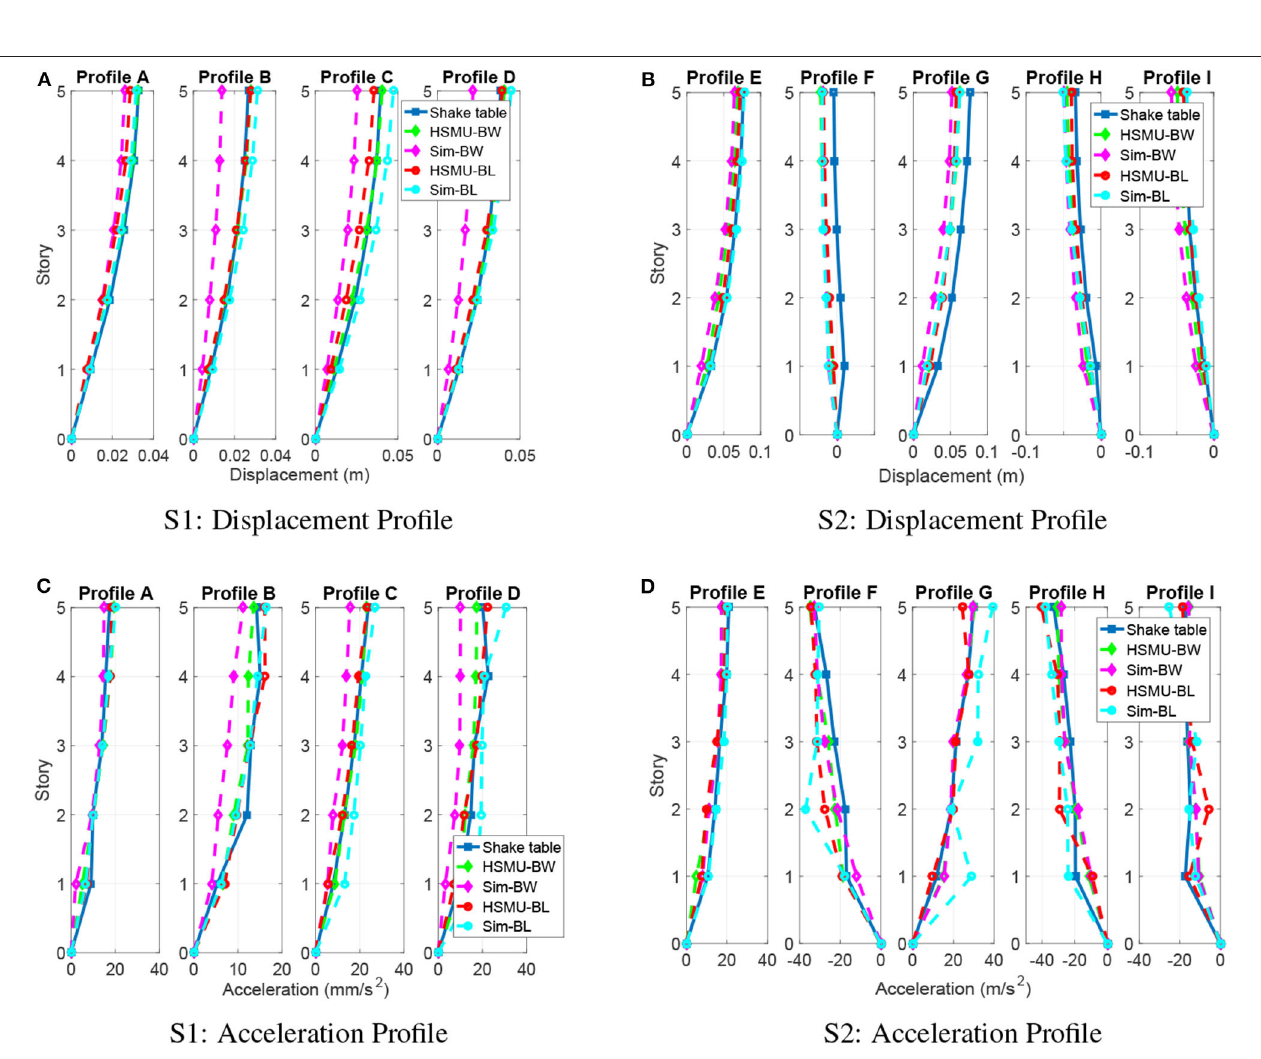
FIGURE 10 | Displacement and acceleration profiles at peak locations. (A) S1: displacement profile, (B) S2: displacement profile, (C) S1: acceleration profile, (D) S2: acceleration profile.